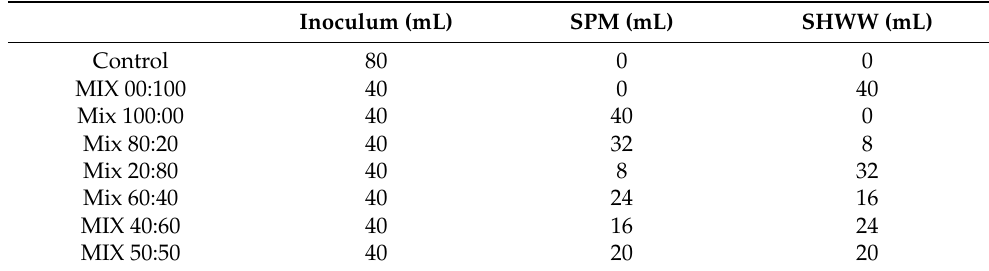
Table 3. The mixing ratio of the